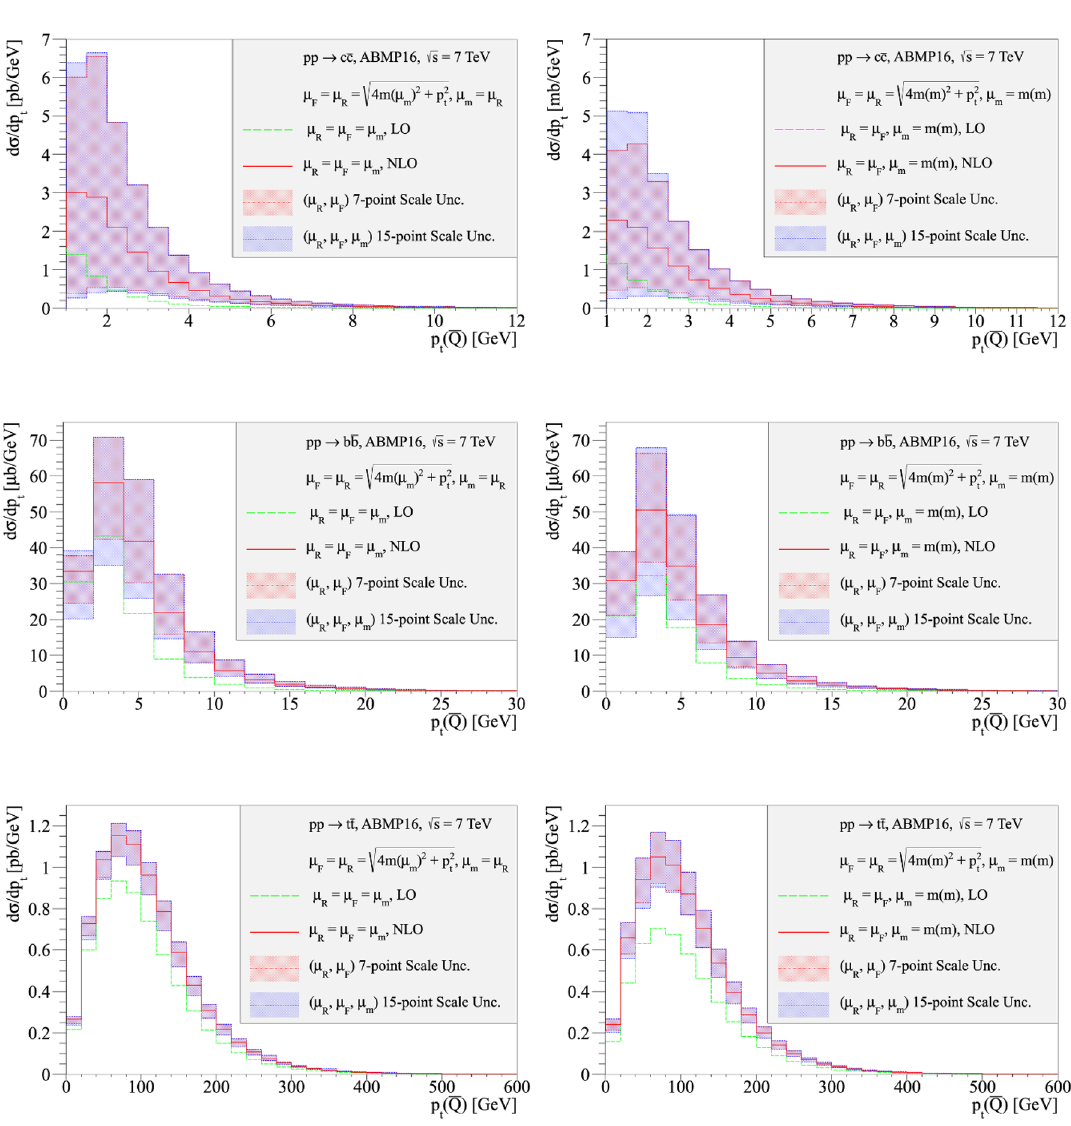
Figure 16 . Same as figure 15, but for a different scale variation procedure. For central predictions, q computed with µ R = µ F = µ 0 = p 2 + 4 m 2 ( µ m ) the panels on the left use a dynamical mass T Q renormalization scale µ m = µ R , whereas the panels on the right use the static mass renormalization scale µ m = m Q ( m Q ) , with m Q ( m Q ) fixed to the values of the PDG ( m c ( m c ) = 1.28 GeV, m b ( m b ) = 4.18 GeV, m t ( m t ) = 163 GeV). Scale variations are computed according to the procedure (ii) discussed in the text, with fully independent variations of the involved scales. The ( µ R , µ F ) 7-point scale variation bands at fixed µ m = µ 0 are shown in red, whereas the ( µ R , µ F , µ m ) 15-point scale variation bands are shown in blue. µ m is varied independently of µ R and µ F in the interval [1/2,2] around its central value. Central LO predictions, computed using the same ( µ R , µ F , µ m ) and m ( µ m ) values as the central NLO ones, are also shown (green dashed line). The α S ( M Z ) values, the α S evolution and the central PDFs extracted from the ABMP16 NLO fit are used in all parts of the computation, both for NLO and for LO